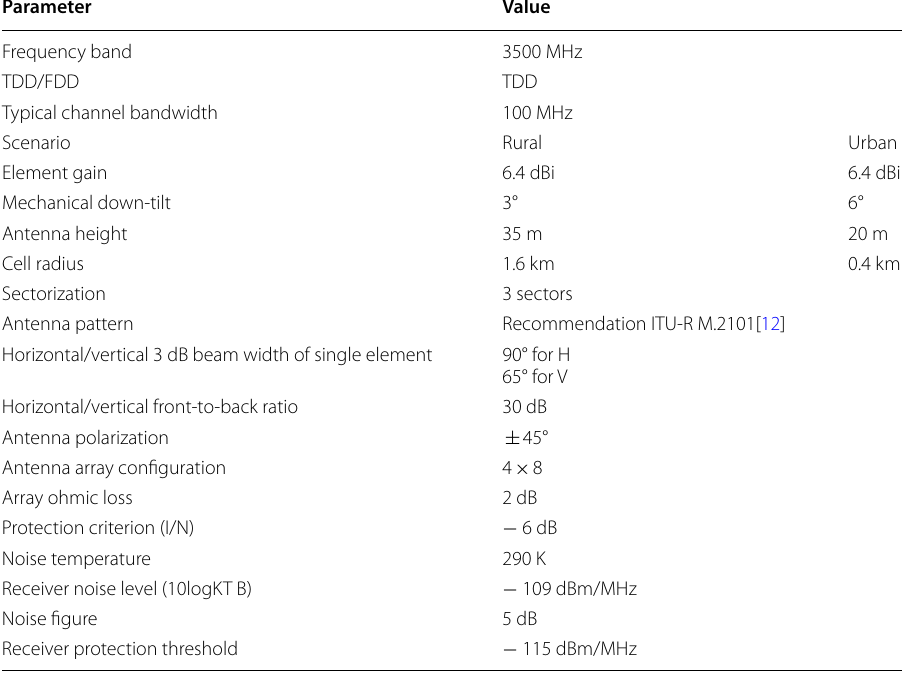
Table 3 5G mobile communication system